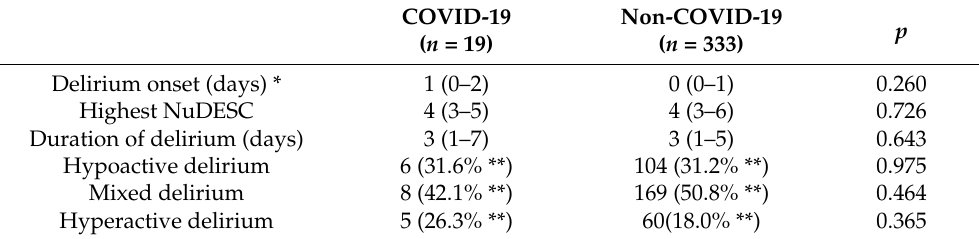
Table 3. Delirium and